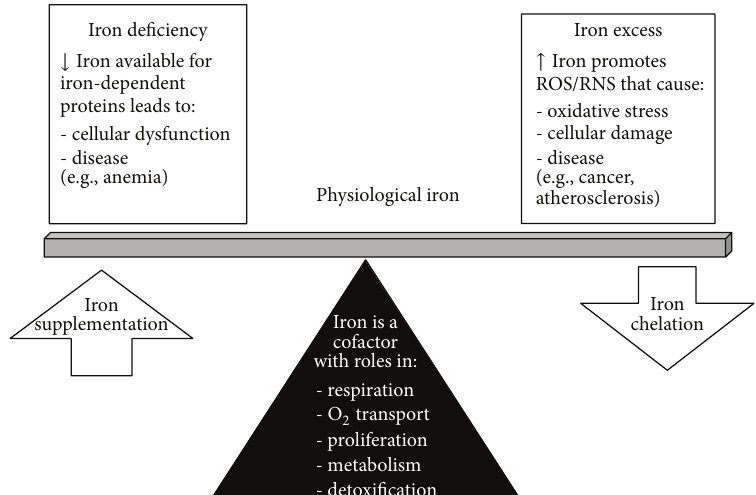
Figure 1: Role of iron in the development of disease.